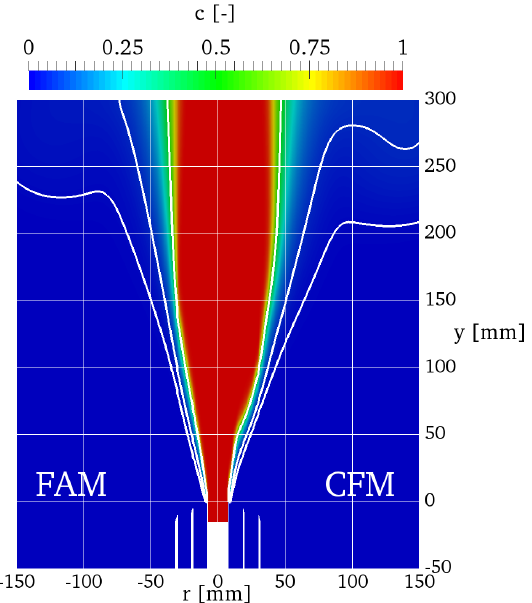
Figure 8. Case A-r: comparison between normalized progress variable c fields achieved with FAM (left half) and CFM (right half) models, including iso c = 0.01 (from burner axis towards increasing radii,